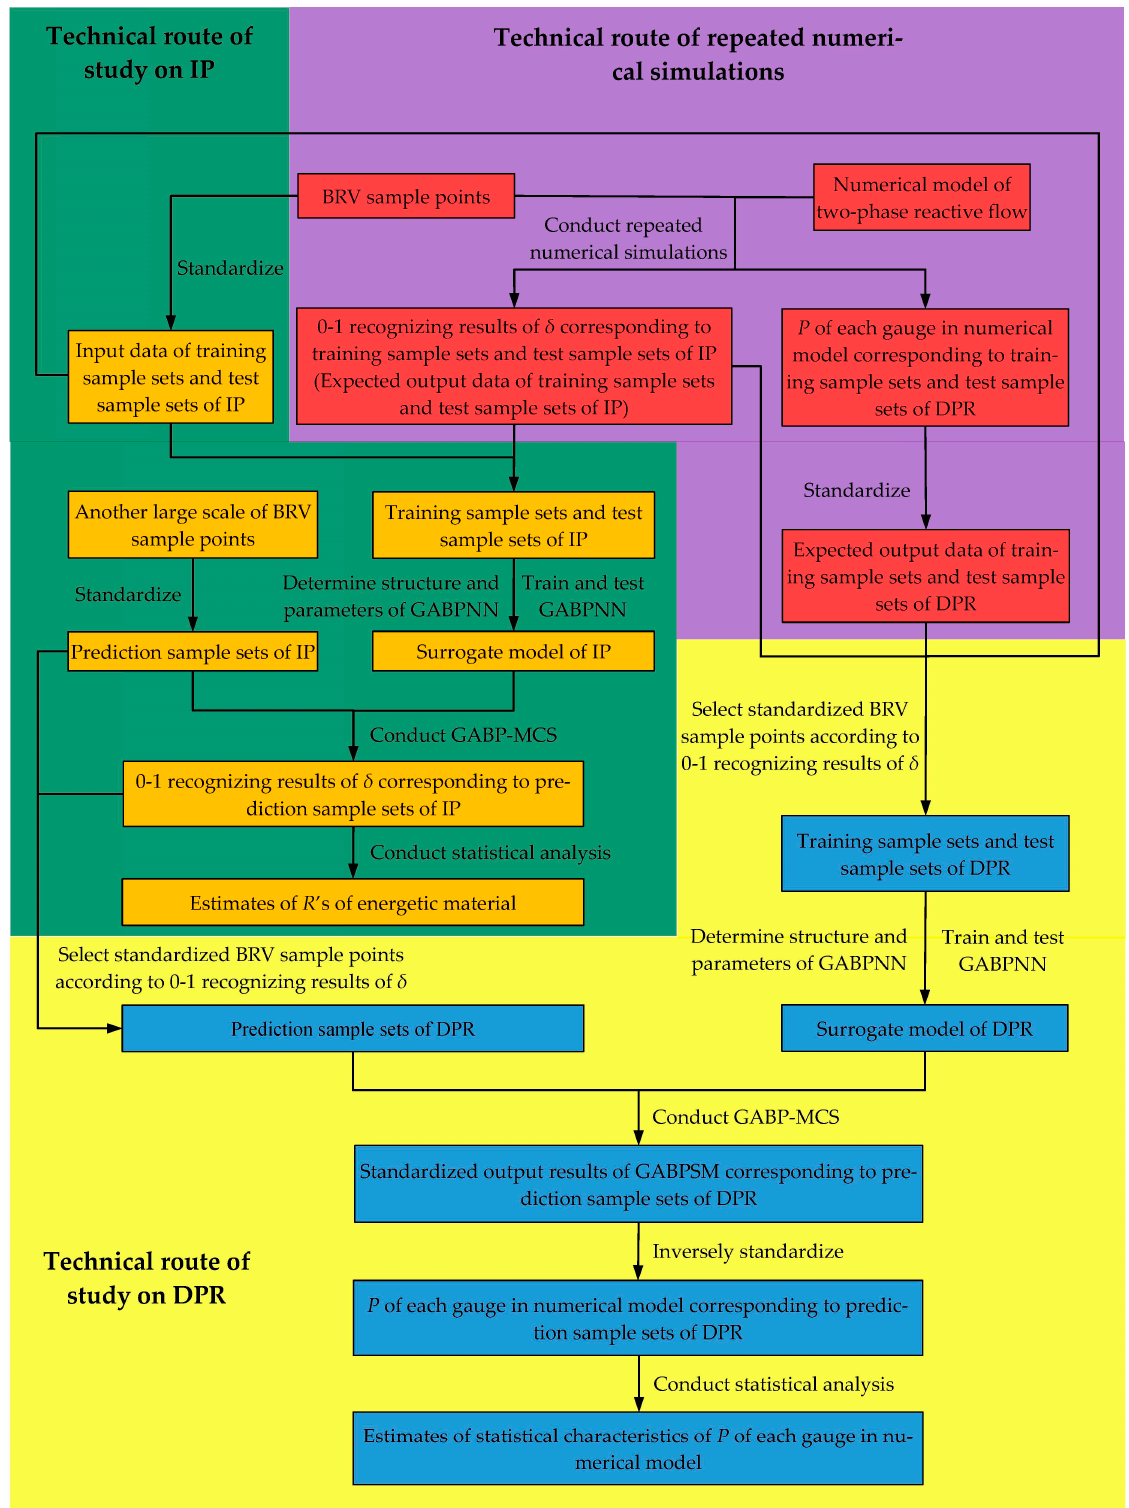
Figure 2. The global technical route to addressing